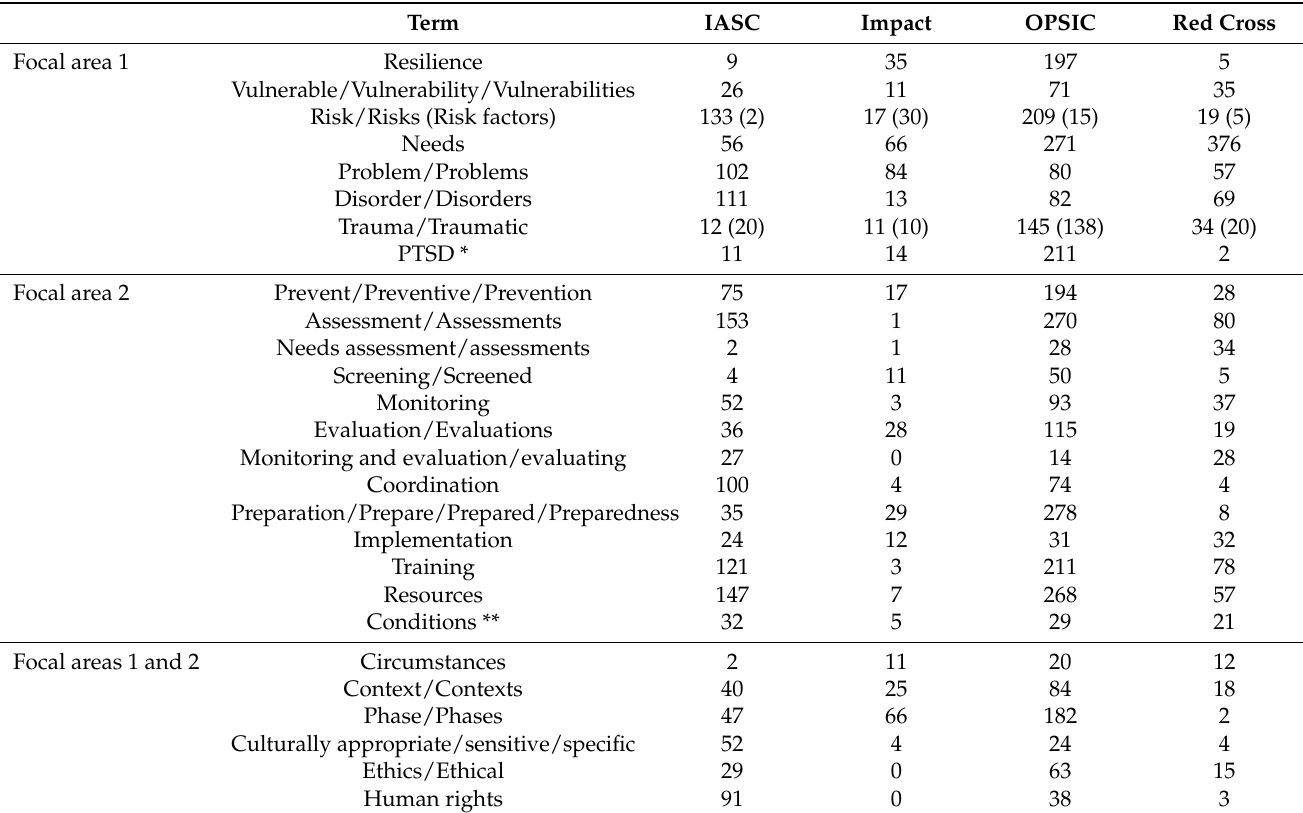
Table 2. Frequency of Terminology in MHPSS